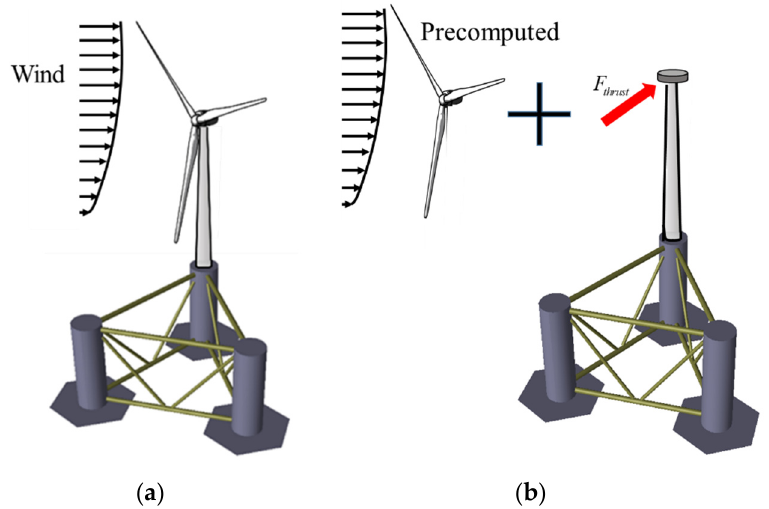
Figure 2. Illustration of coupled and simplified method: ( a ) Coupled method; ( b ) Simplified method.